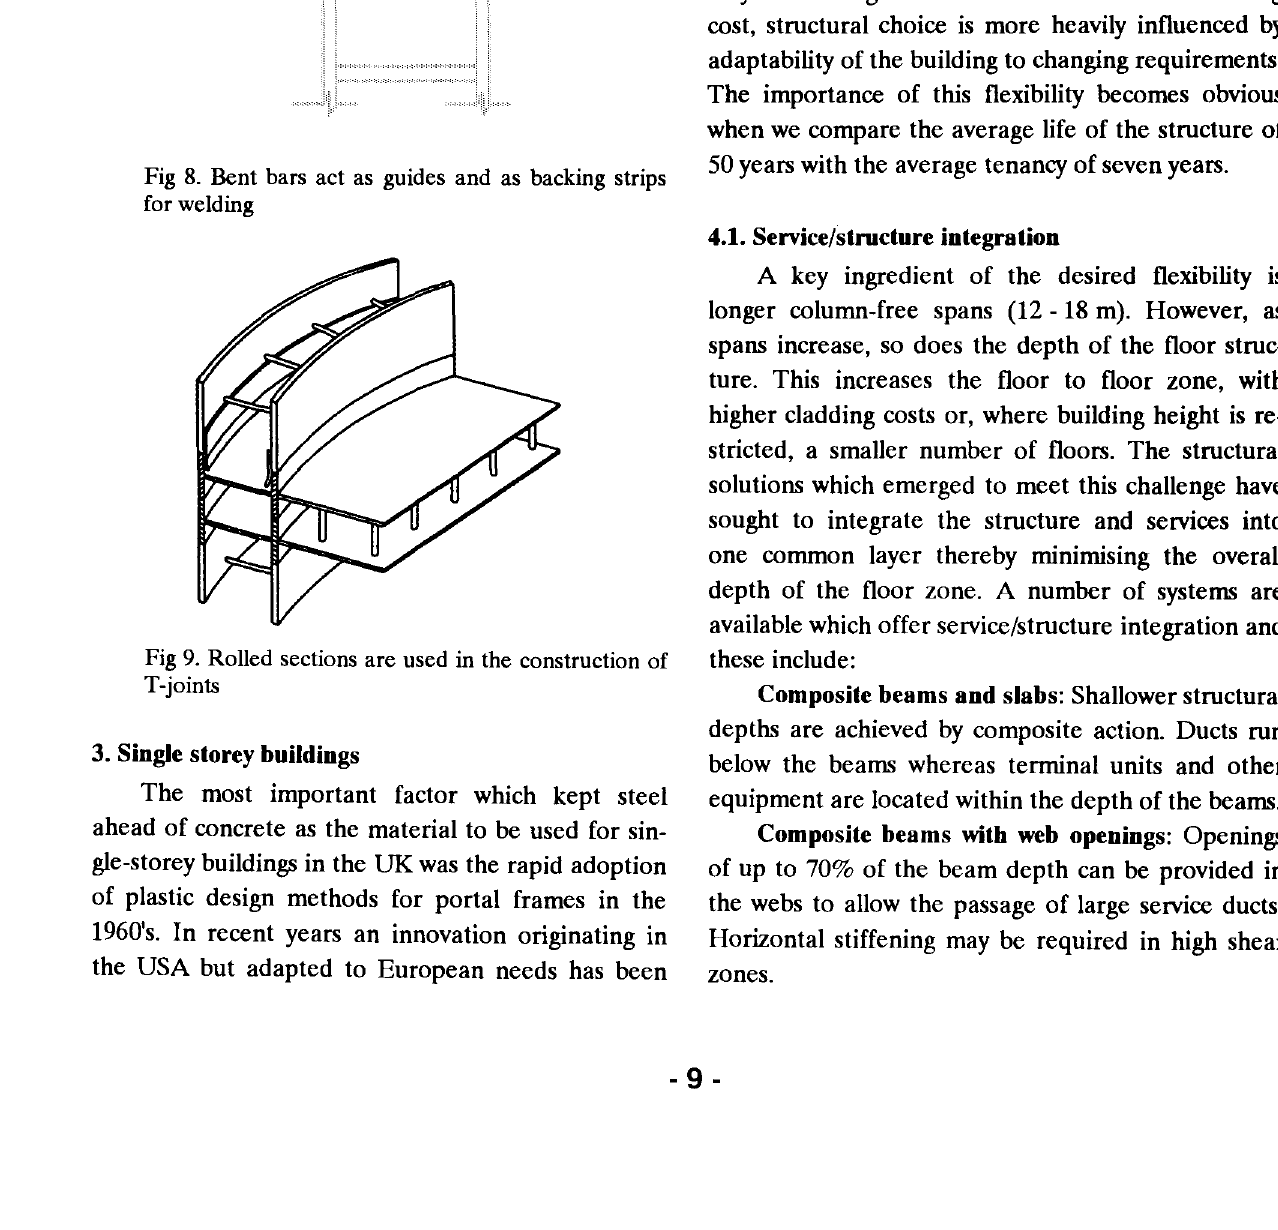
Fig 7. Typical Bi-Steel panel with friction welded bars At T -joints, the use of rolled sections is proposed (Fig 9), leading to robust connections. The rounded corners of rolled sections offer further advantages with respect to fatigue where cyclic loading is in volved.